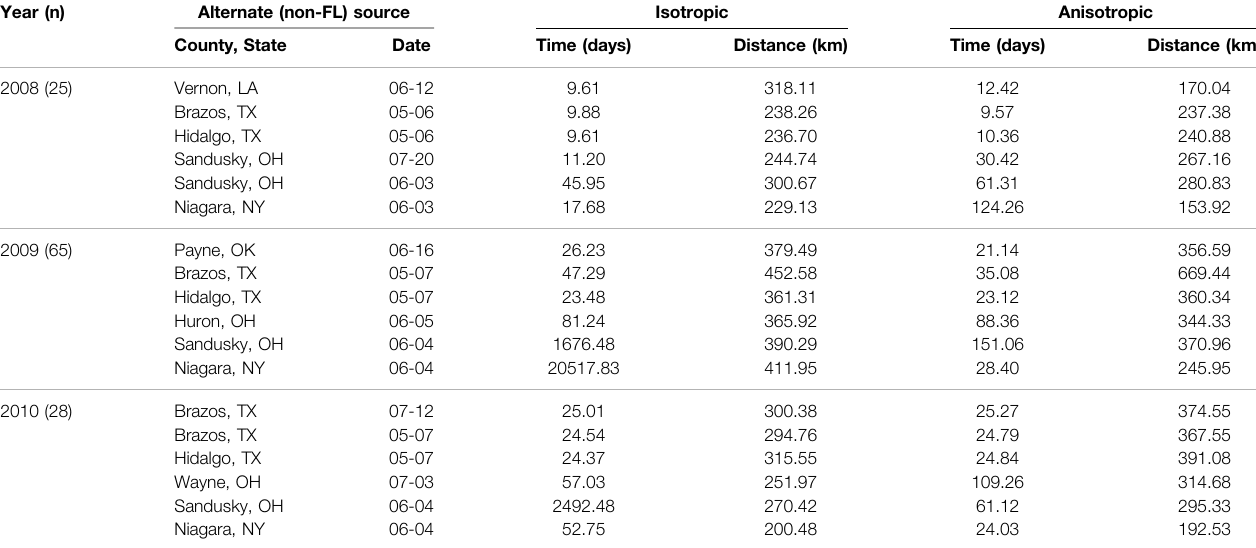
TABLE7| Rootmeansquareerrorsoftimeanddistanceforisotropicandanisotropictwo-sourcemodelsforseveralalternatesourcelocations.Theotherofthetwosources is placed in Florida in the same location and time as in the one-source model.